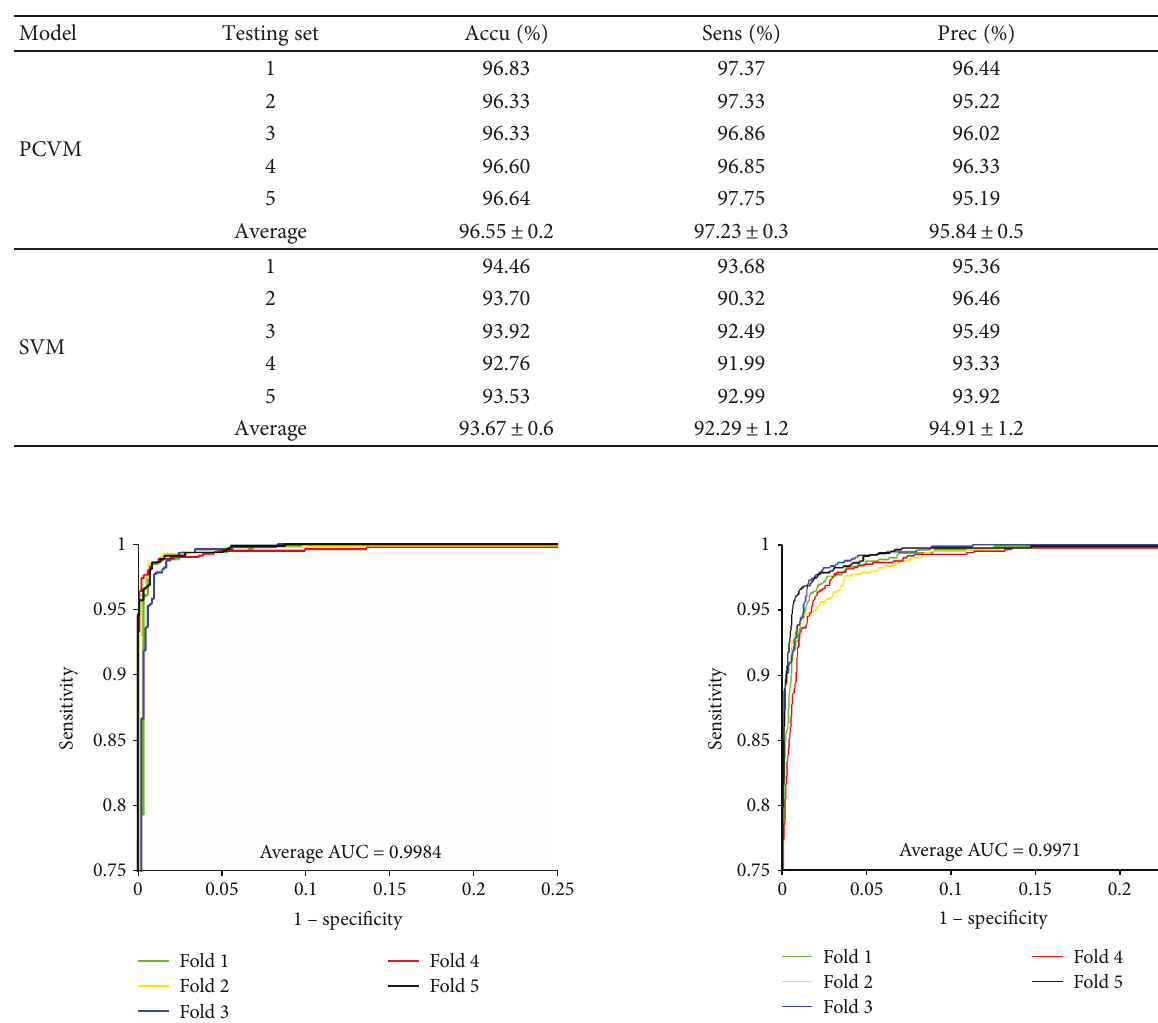
Table 4: The prediction performance comparison of PCVM with SVM.